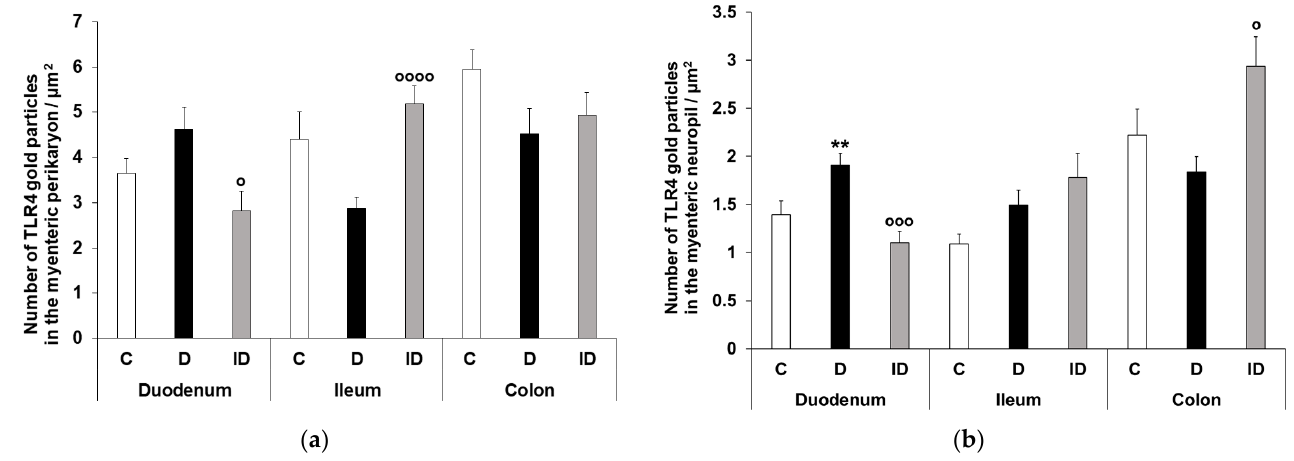
Figure 7. Quantitative evaluation of gold particles labelling TLR4 in perikaryon of myenteric neurons ( a ) and ganglionic neuropil ( b ) from different gut segments of control, diabetic and insulin-treated diabetic rats. TLR4 density increased both in myenteric perykaryon and the neuropil of the diabetic duodenum, decreased in both compartments in the diabetic colon and a subcellular rearrangement of myenteric TLR4-labelling gold particles was revealed in the ileum of diabetics. Statistics: Kruskal-Wallis test with Dunn’s multiple comparisons test. Data are expressed as means ± SEM. ** p < 0.01 (relative to controls); o p < 0.05, ooo p < 0.001, oooo p < 0.0001 (between diabetics and insulin-